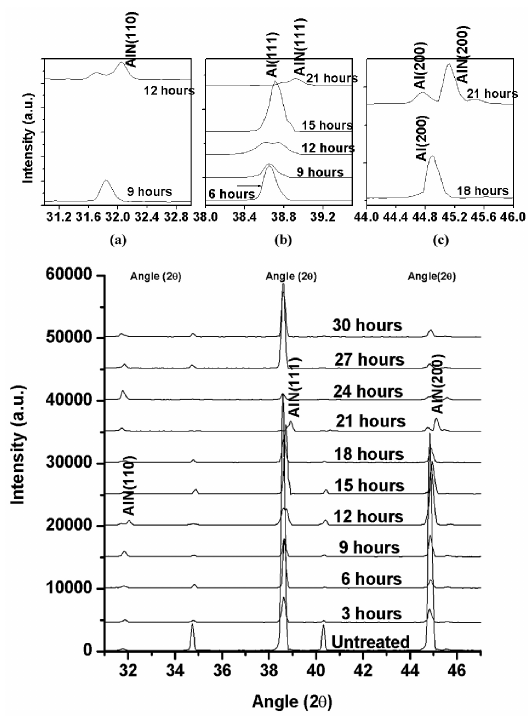
Figure 2. XRD spectra of Al samples nitrided at 0.5 mbar fill pressure for different treatment times (3, 6, 9, 12, 15, 18, 21, 24, 27 and 30 hours). Insets (a), (b) and (c) clearly resolve AlN(110) and (111) and (200) peaks.